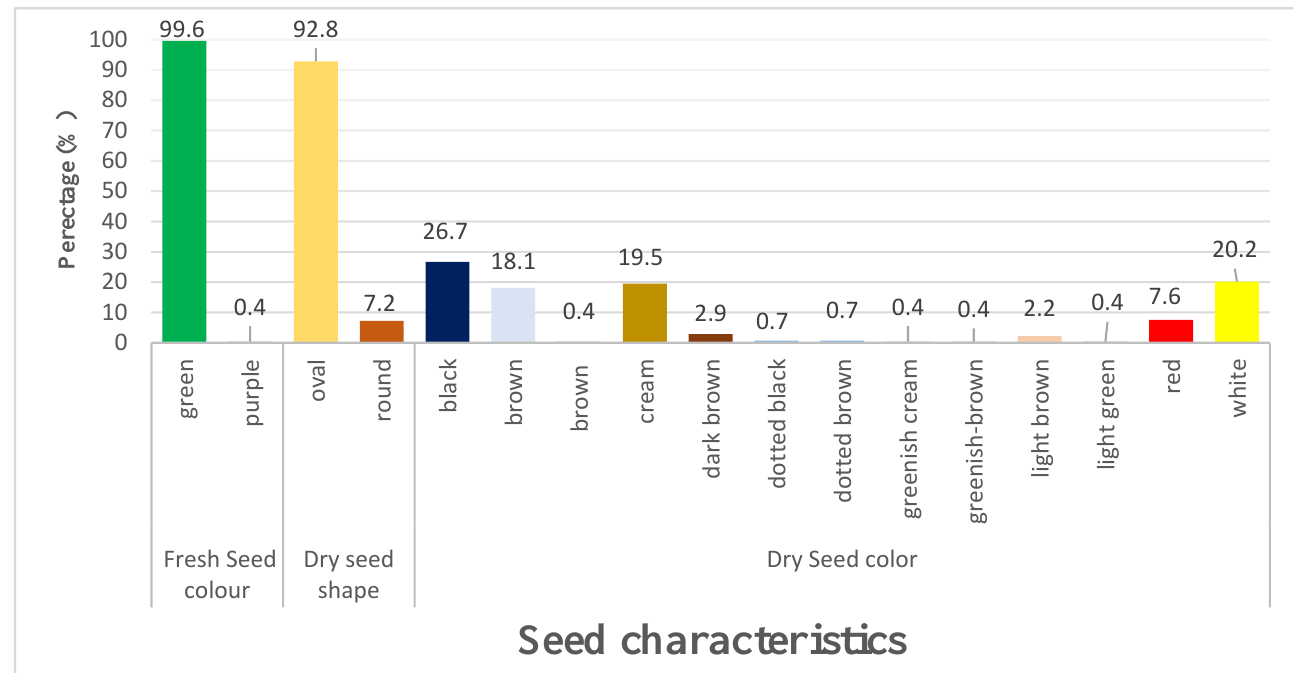
Figure 3. Variation in selected pod characteristics of lablab accessions.